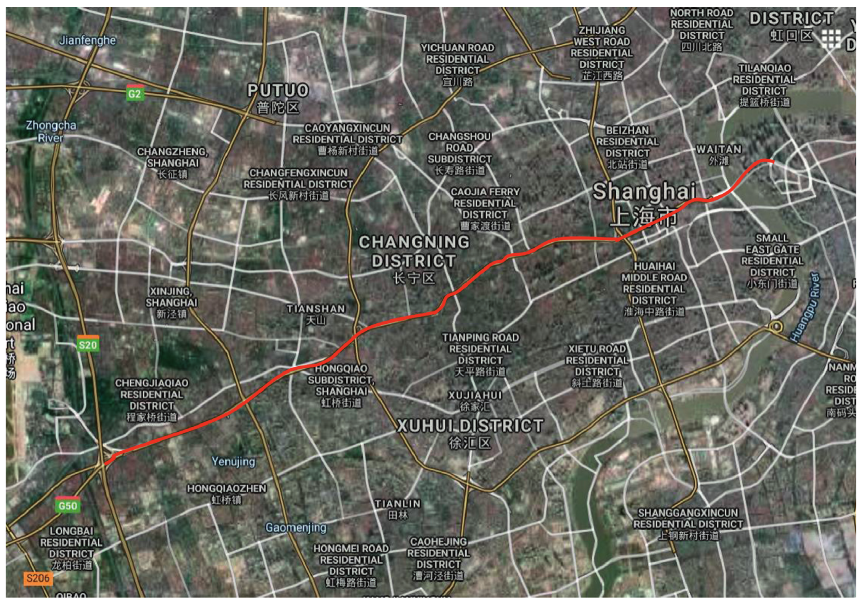
Figure 1: Map of Yanan corridor in Shanghai,